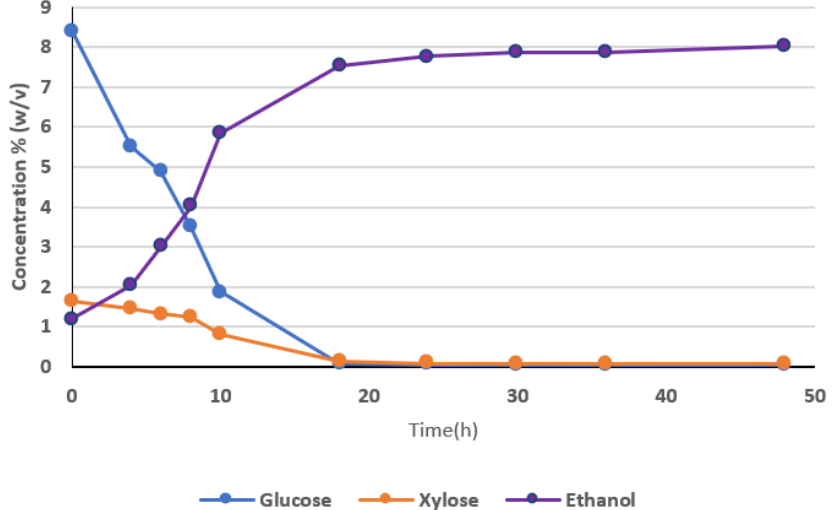
Figure 3. Consumption of glucose and xylose and production of ethanol with saccharified paper/pulp hydrolysate.